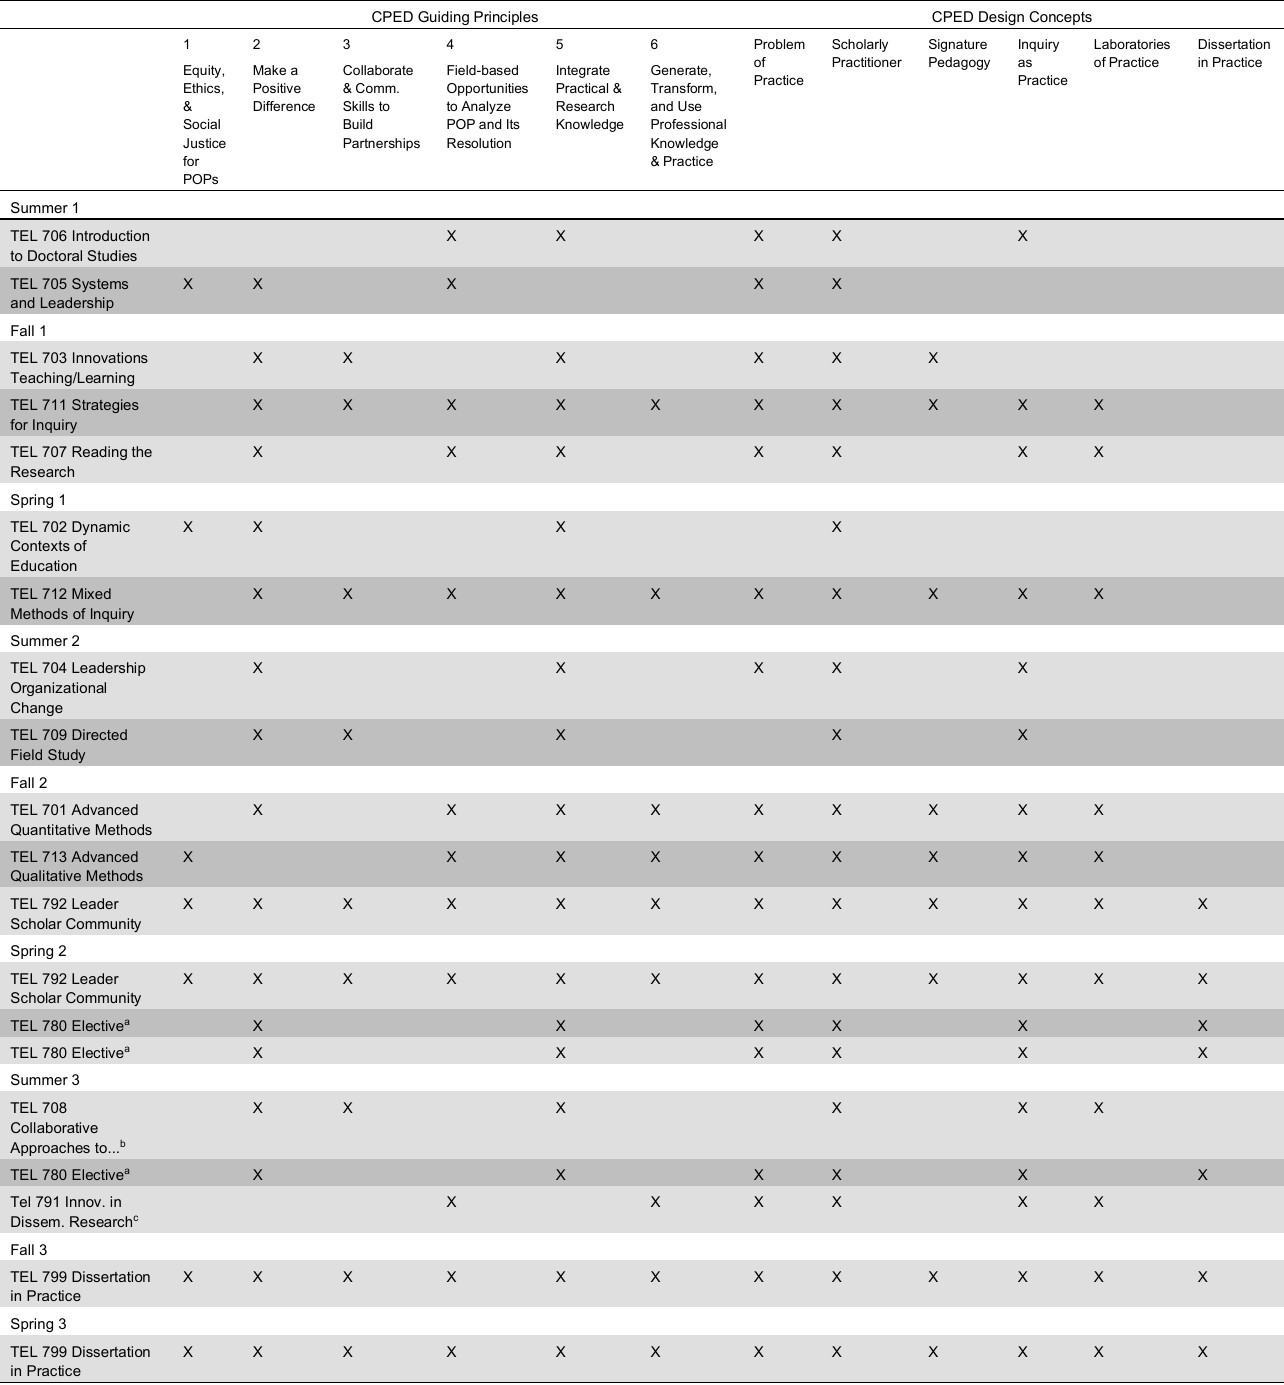
Table 2. Program Courses by CPED Guiding Principles and Design